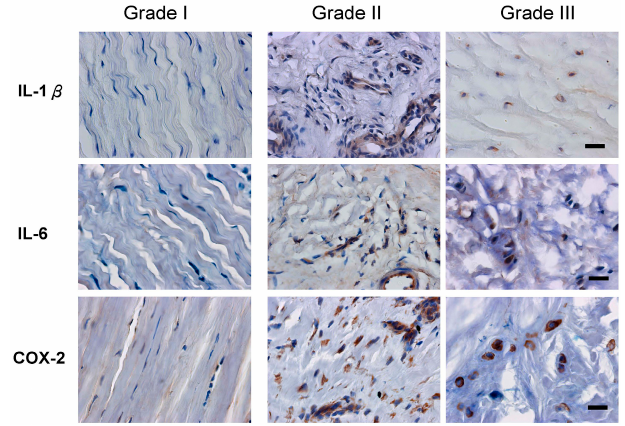
Figure 4. The expression of interleukin (IL)-1 β , IL-6, and cyclooxygenase (COX)-2 in tissue was related to the disease severity. Serial sections of three grades (I-III) were stained with IL-1 β , IL-6, and COX-2 antibodies, respectively. IL-1 β , IL-6, and COX-2 were expressed in tissue from patients with grade II and grade III cases of de Quervain’s disease (immunohistochemical staining, 400× magnification, scale bar = 10 μ m).